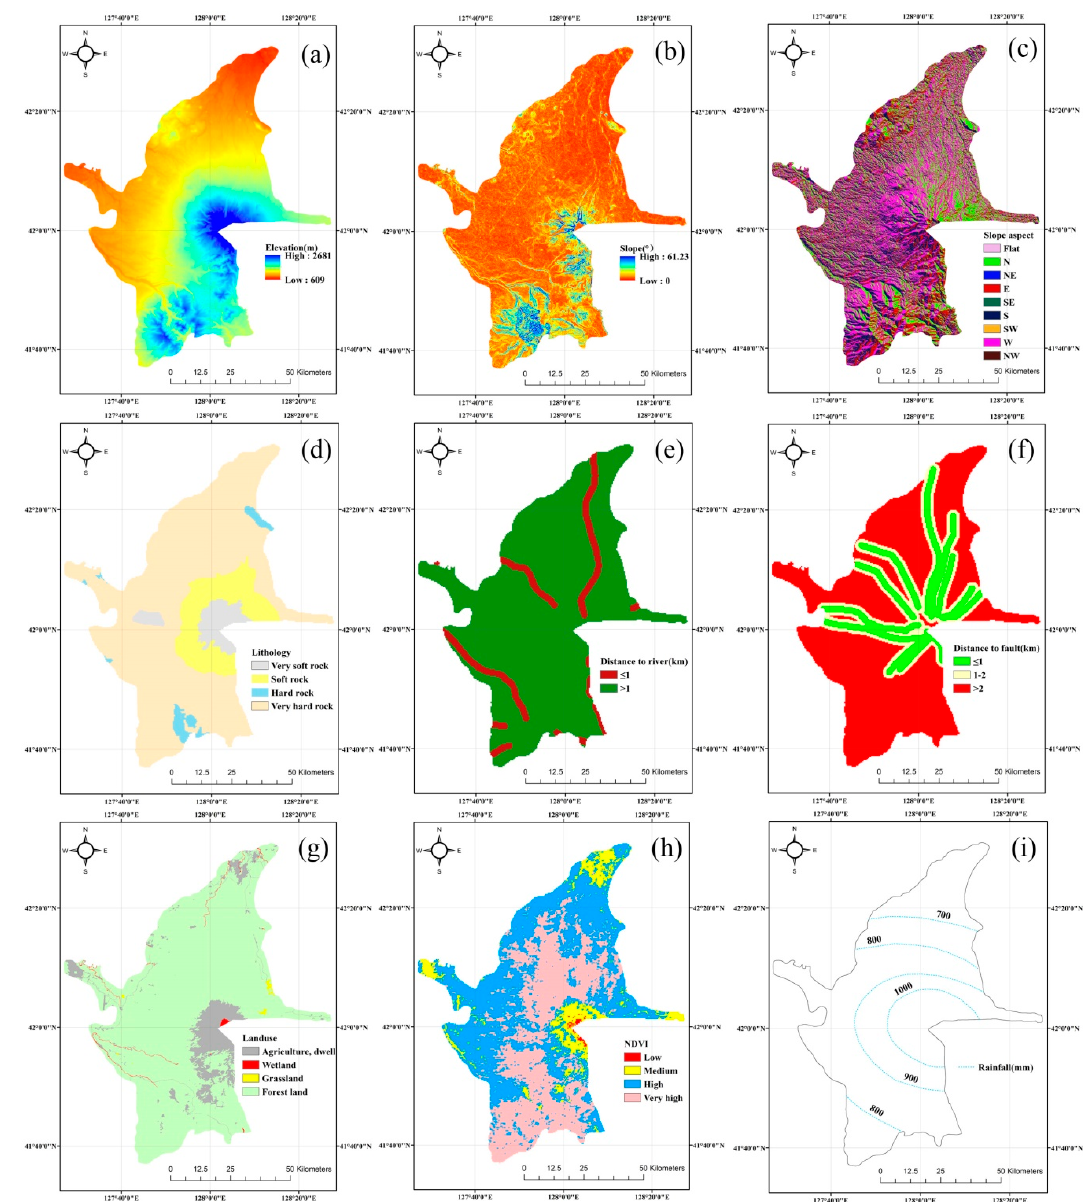
Figure 6. Condition parameters: ( a ) Elevation, ( b ) Slope, ( c ) Slope aspect, ( d ) Lithology, ( e ) Distance to river, ( f ) Distance to fault, ( g ) Land use, ( h ) NDVI, ( i ) Rainfall.